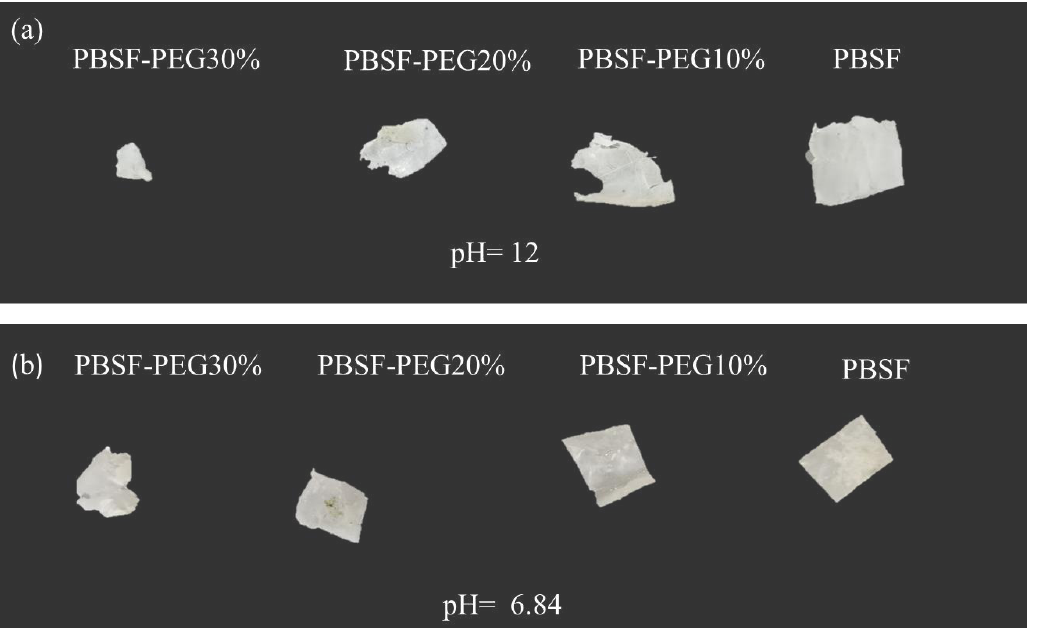
Figure 9. Photographs of the PBSF-PEG films after ( a , b ) hydrolytic degradation in NaOH solution and PBS solution.